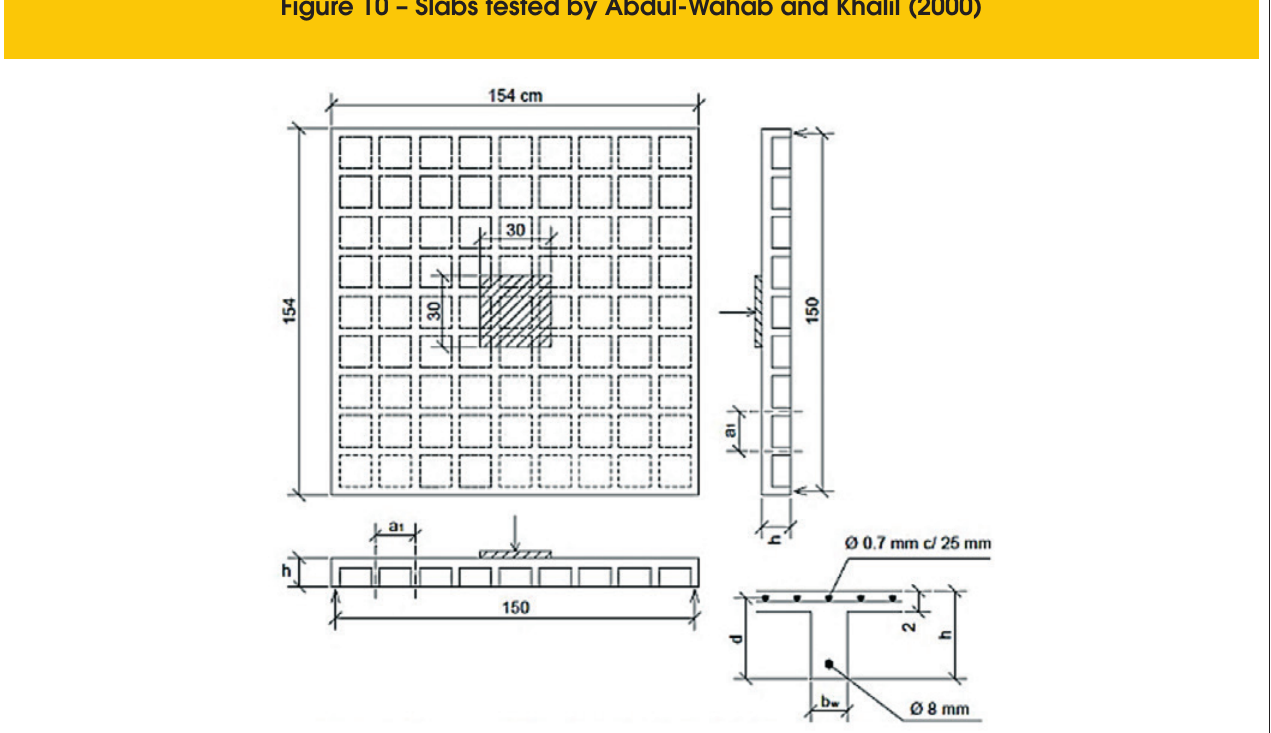
Figure 10 – Slabs tested by Abdul-Wahab and Khalil (2000)